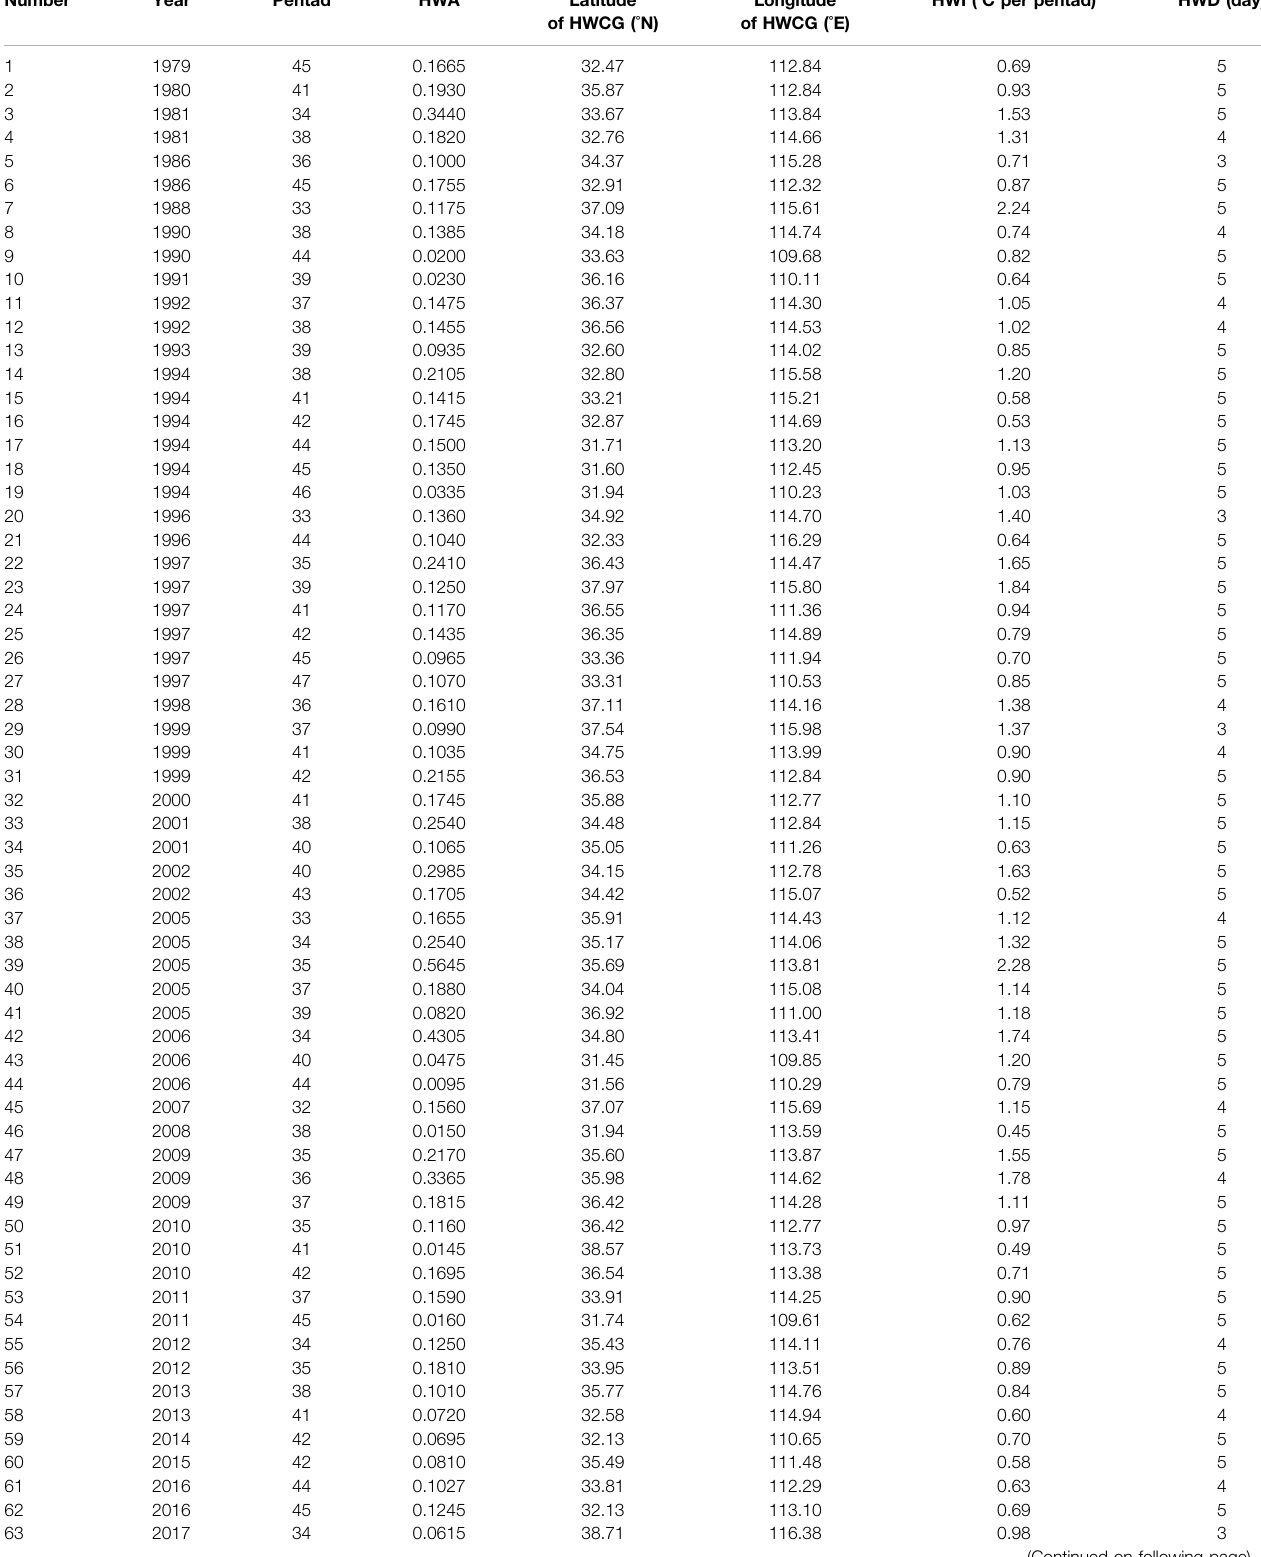
TABLE A2 | Same as Table A1 , but for RPHWs in NCC.